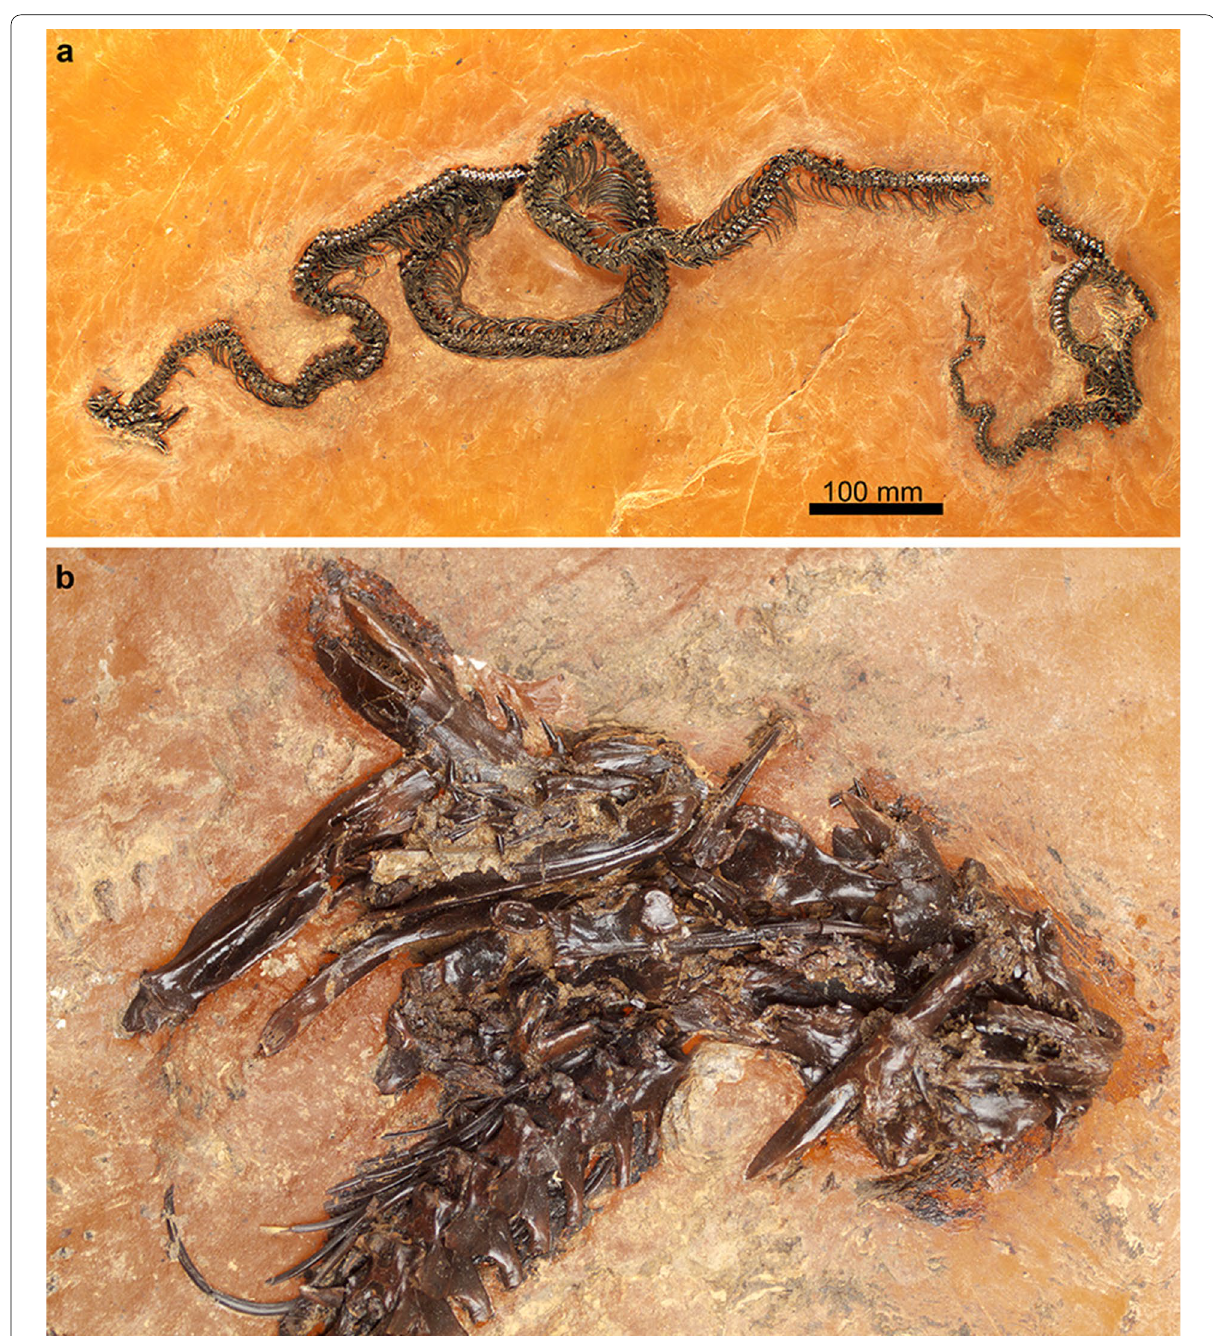
Fig. 53 Eoconstrictor fischeri from Messel: a articulated skeleton with skull (SMF-ME 2504); b close up of skull remains of the same specimen. Specimen originally figured by Schaal (2004:figs. 6,